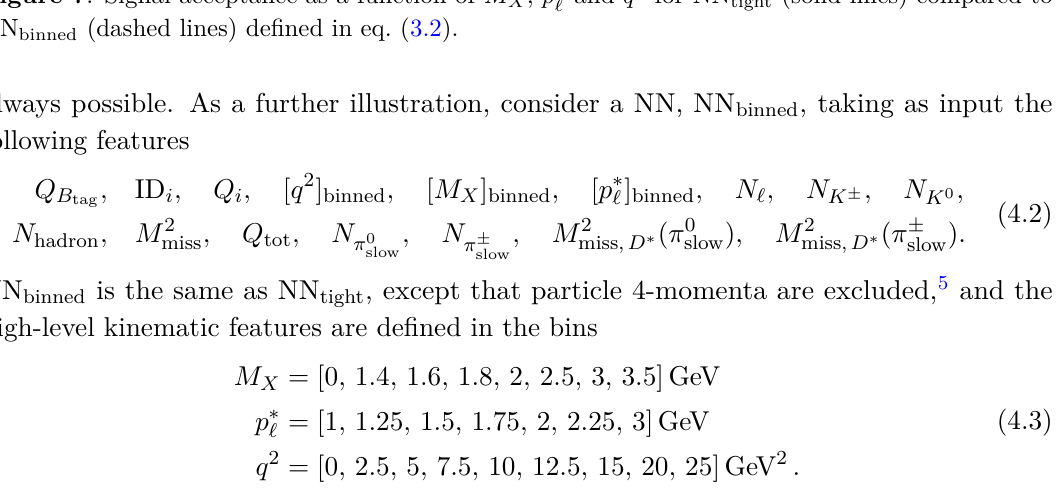
and q 2 for NN (solid lines) compared to tight ‘